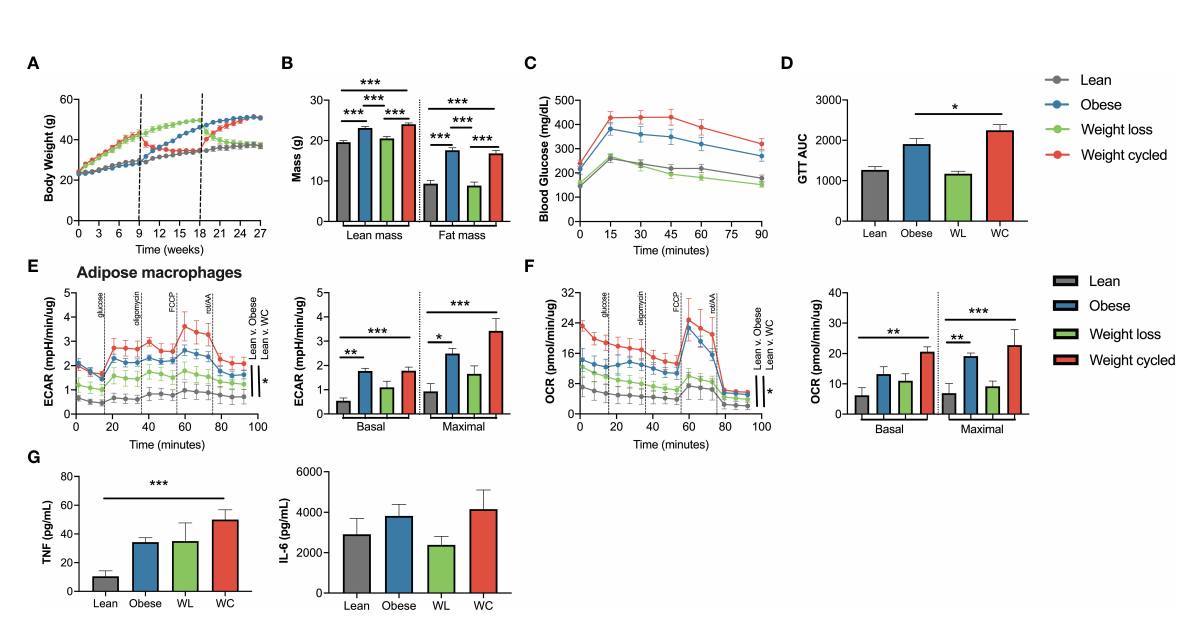
FIGURE 5 Weight cycling augments cell metabolism and basal cytokine production from adipose macrophages. Lean, obese, weight loss (WL) and weight cycled (WC) mice were generated over 27 weeks as in Figure 1A. (A) Body mass over time measured weekly with diet switch indicated by dashed lines. (B) Lean and fat mass measured by nuclear magnetic resonance. (C) Blood glucose during an intraperitoneal glucose tolerance test (1.5 g dextrose/kg lean mass) at 27 weeks and (D) area under the curve. (E) Extracellular acidi fi cation rate (ECAR) and (F) oxygen consumption rate (OCR) of epididymal adipose macrophages selected by 2-houradherence during modi fi ed mitochondrial stress test by Seahorse metabolic analyzer. (G) TNF and IL-6 production over 24 hours by ELISA in adipose macrophages selected by 2-houradherence and normalized by protein concentration. Data are means ± SEM of 10-12 mice for (A – D) , 5-14 mice for (E – G) , representative of 2 independent experiments. * p <0.05, ** p < 0.01, *** p